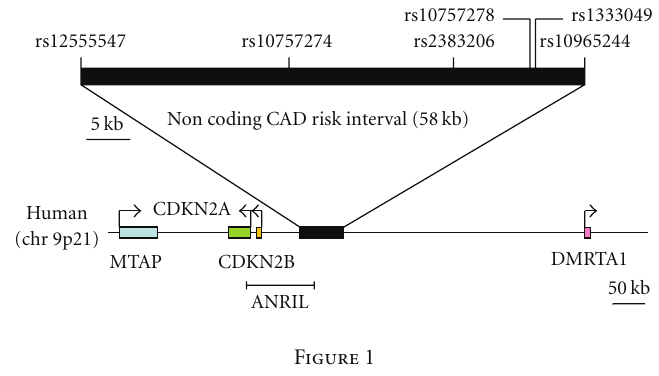
Figure 1: The 58 kb non-coding CAD risk interval on chromosome